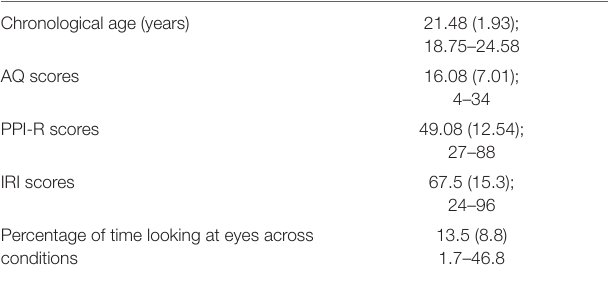
TABLE 1 | Participant characterization